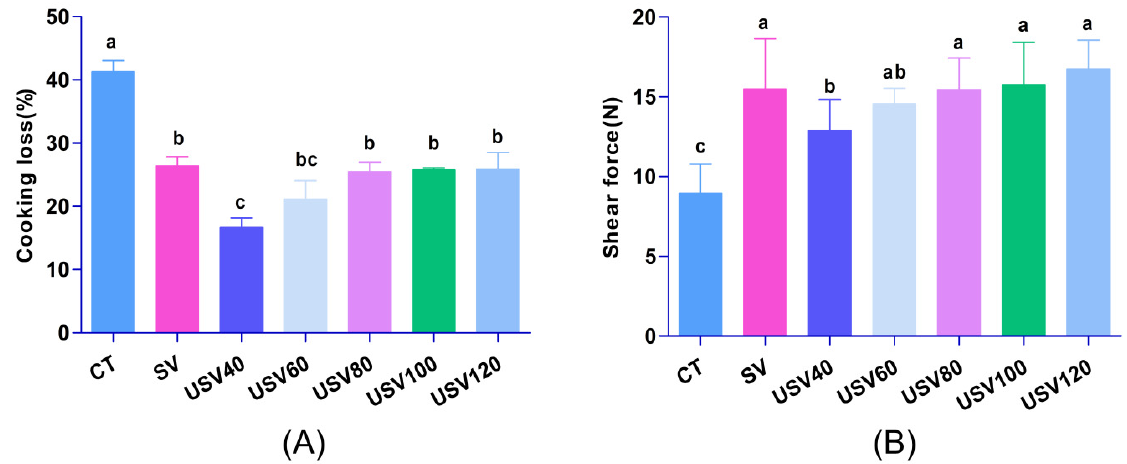
Figure 2. Changes in cooking loss ( A ) and shear force ( B ) of spiced beef under different thermal treatments. CT: conventional cooking of spiced beef; SV: sous-vide cooking of spiced beef; USV40~USV120: ultrasound-assisted sous-vide cooking of spiced beef for 40~120 min. Different lowercase letters indicate statistically significant difference at ( p < 0.05).